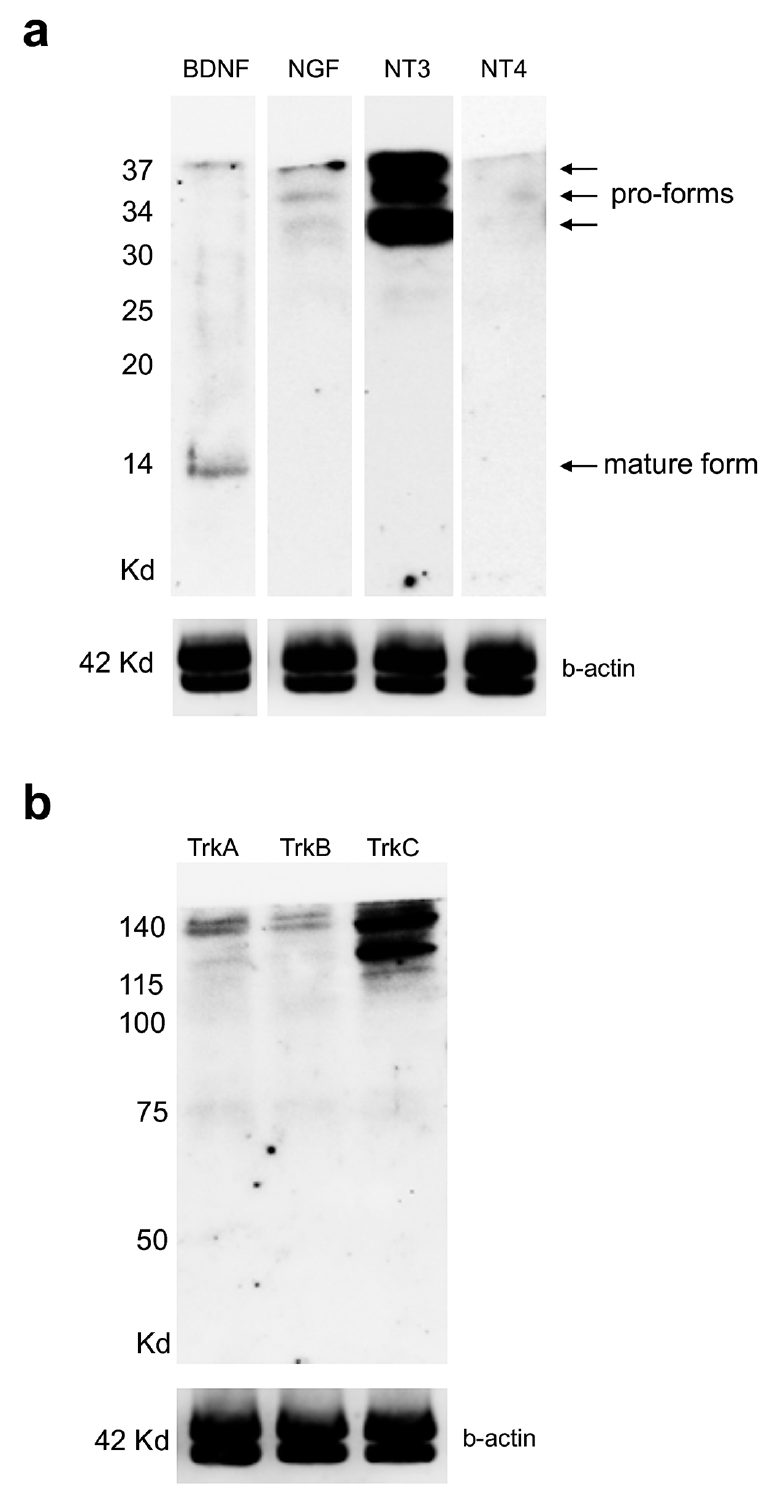
Figure 5. Western blotting analysis for neurotrophins and receptors in adult zebrafish kidney. ( a ) Western blot to detect BDNF, NGF, NT-3, and NT-4 in adult zebrafish kidney. Two bands for BDNF of 14 kD and 37 kD; 3 bands for NGF of 30 kD, 34 kD, and 37 kD; 3 bands for NT-3 of 30 kD, 34 kD, and 37 kD. NT4 is not detected. ( b ) Western blot to detect TrkA, TrkB, and TrkC in adult zebrafish kidney. Three bands for TrKA at 75 kD, 115 kD, and 140 kD. One band of 140 kD for TrkB and 2 bands of 115 kD and 140 kD for